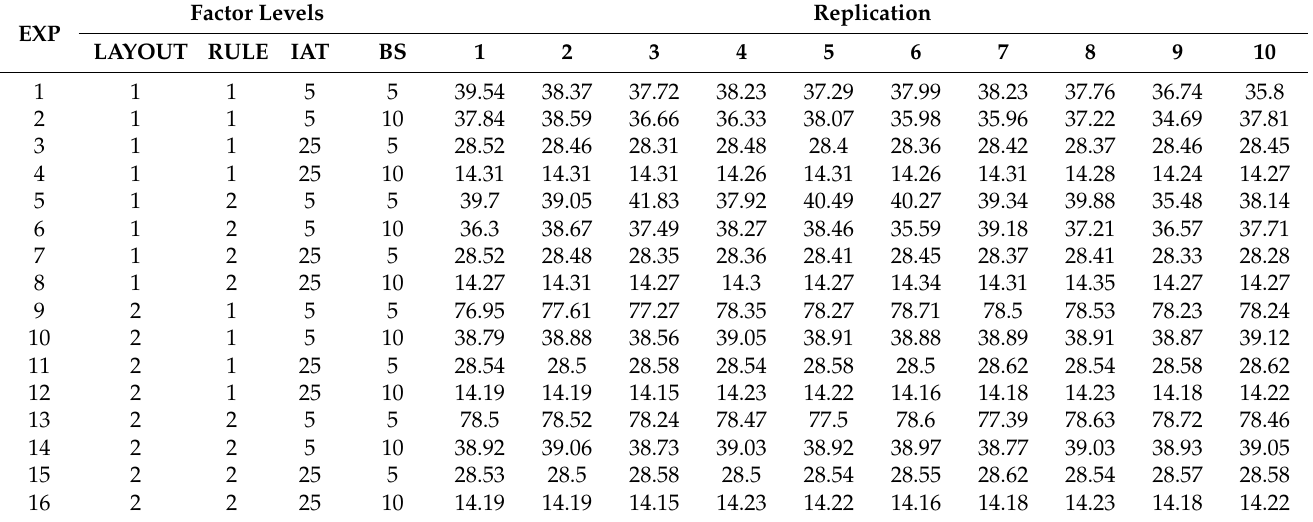
Table A3. TR simulation results according to DoE.